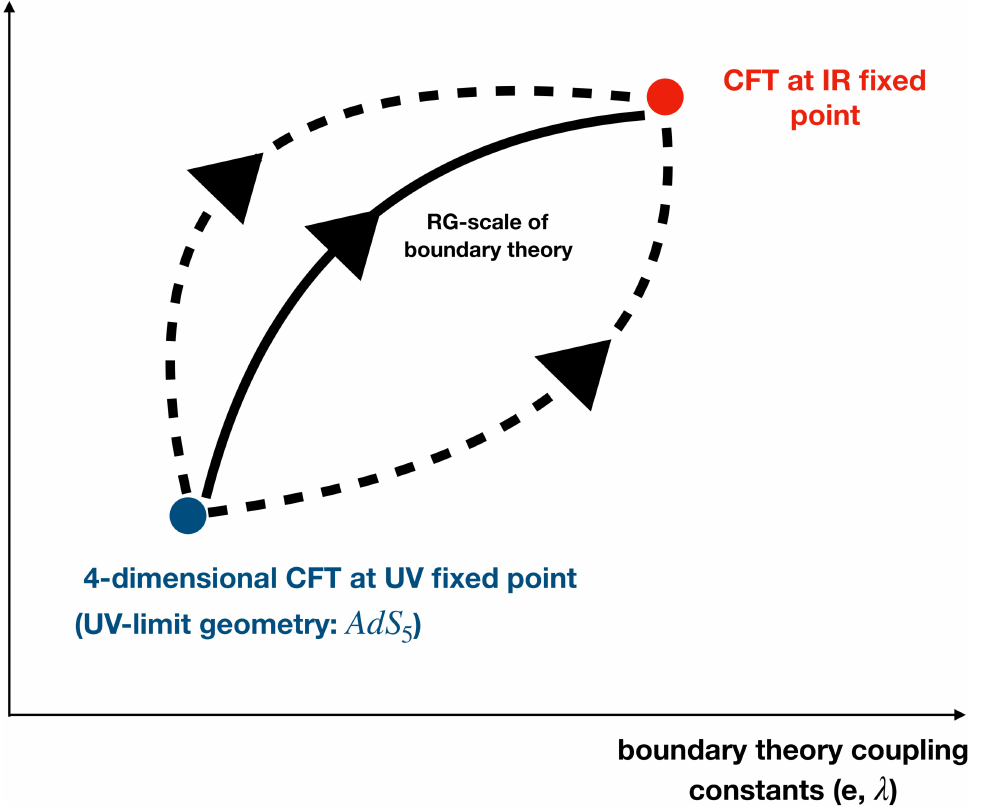
Figure 2 . Schematic plot of the RG-flow in the space of field theories, parametrized by the gauge coupling constant e and the ’t Hooft coupling λ